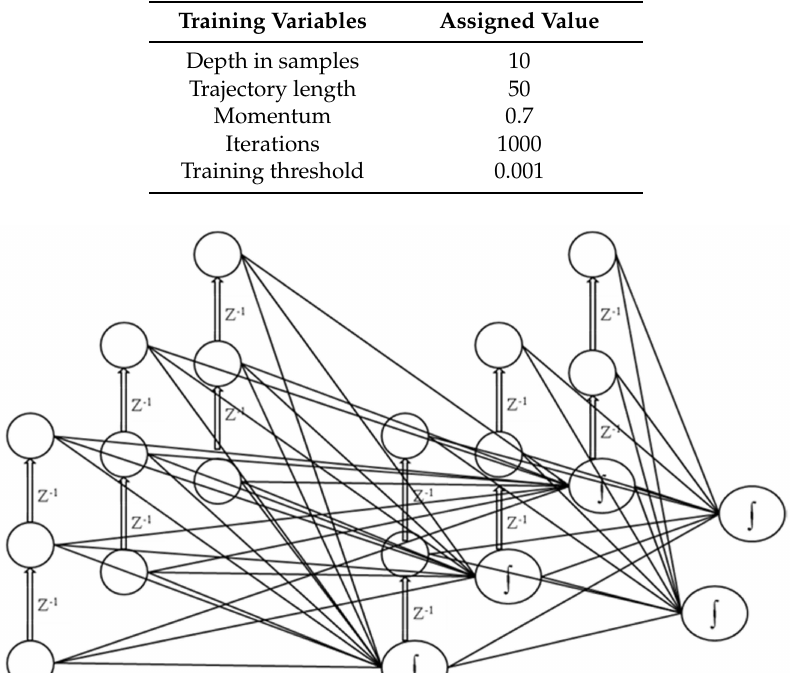
Figure 5. Architecture of the TLRN